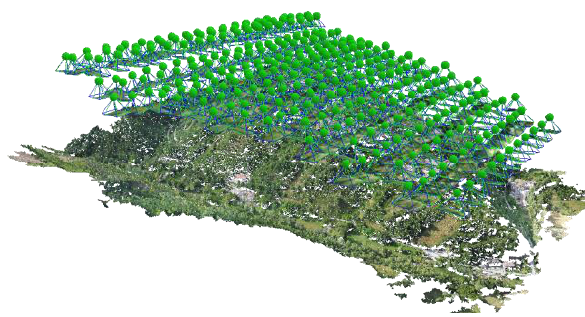
Figure 8. 3D view of the photogrammetric block (303 images).